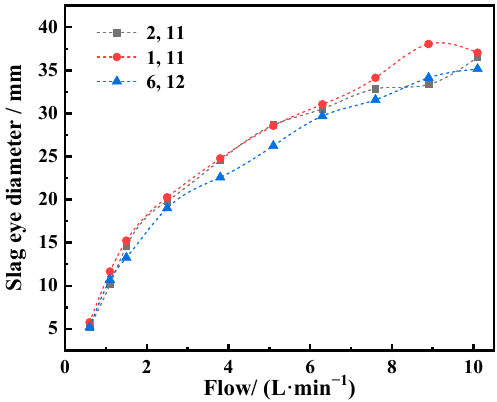
Figure 11. Slag eye diameter of double holes at different blowing rates.